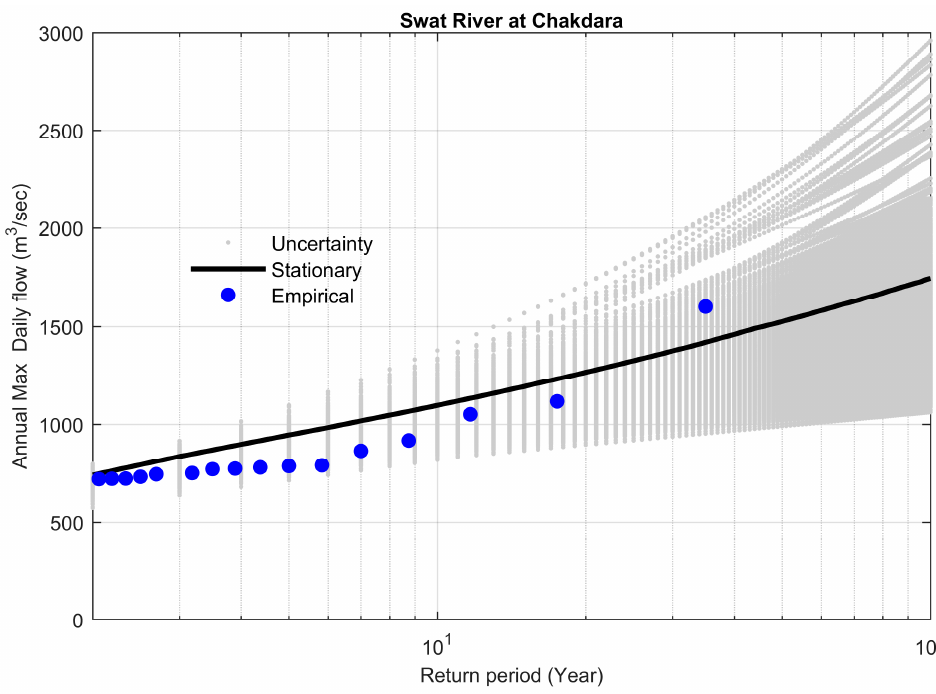
Figure 15. FFCs at site 9, along with stationary uncertainty bounds for the year 1991.